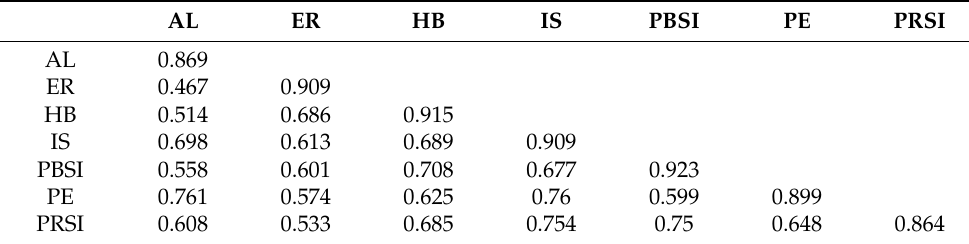
Table 5. Fornell-Larcker Criteria for the Action